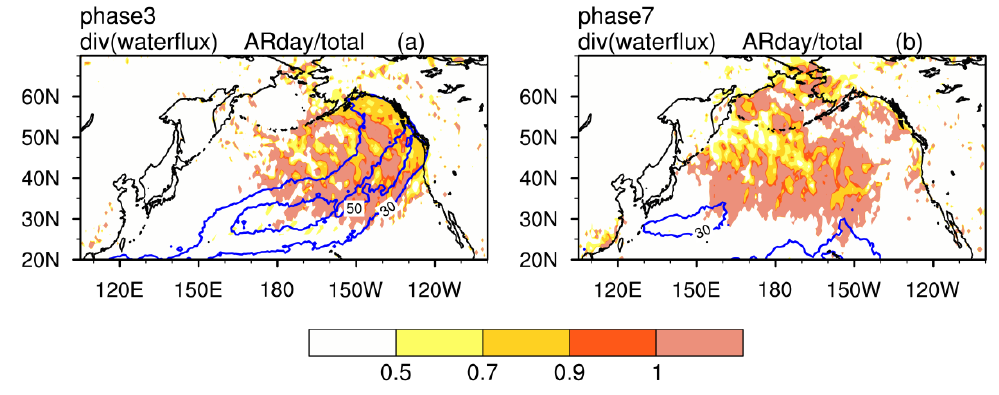
Figure 8. As in Figure 7, but for ∇· IVT.